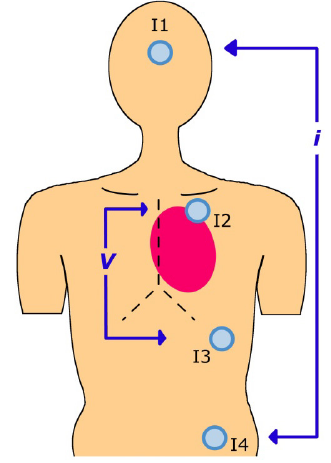
Figure 3: Electrode configuration. A small current ( i ) is applied through the outer two electrodes I1 and I4. The inner two electrodes I2 and I3 measure the impedance induced voltage difference ( V ) over the heart (indicated with an oval). The ECG is obtained from these inner electrodes